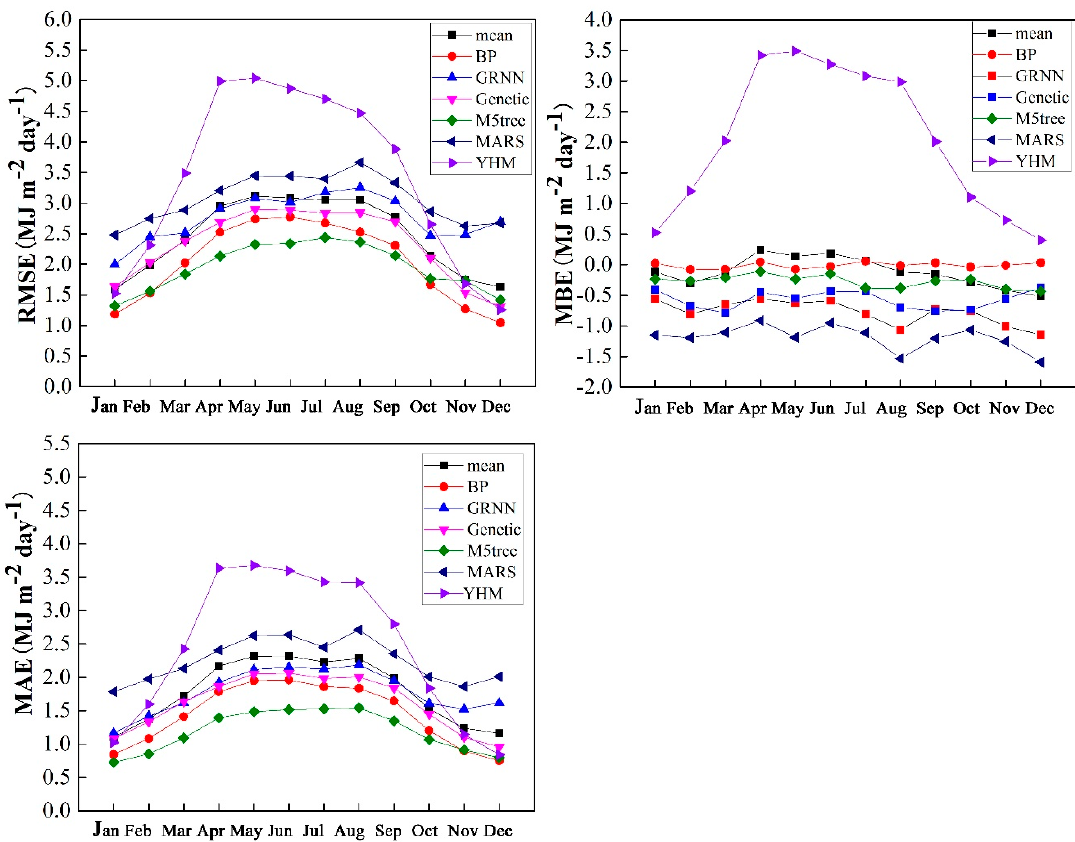
Figure 7. Monthly changes of RMSE , MBE and MAE used to verify estimated DHI using BP, GRNN, Genetic, M5Tree, MARS, and YHM.